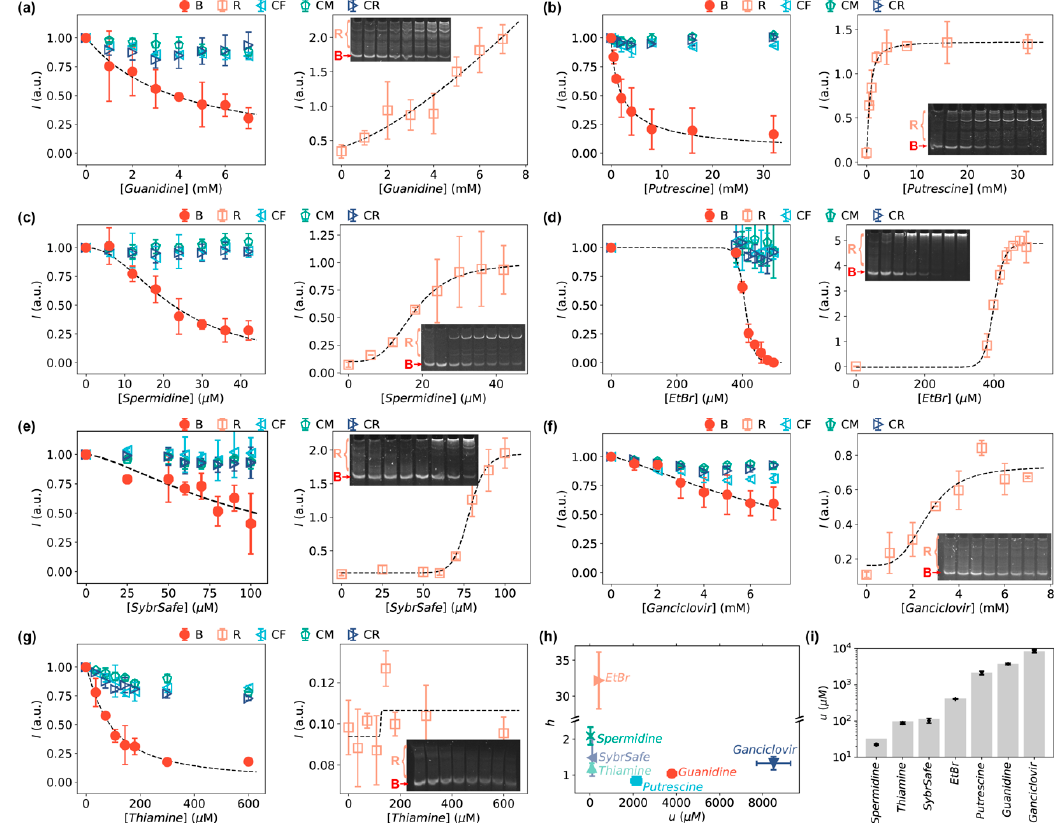
Figure 4. Intensities of the bands of DNA bows (red circles), relaxed DNA loops (orange squares), and linear DNA controls (cyan triangles, green pentagons, blue triangles) in the presence of small organic molecules at increasing concentrations: ( a ) guanidine, ( b ) putrescine, ( c ) spermidine, ( d ) ethidium bromide, ( e ) SYBR safe, ( f ) ganciclovir, and ( g ) thiamine. Insets are the representative, cropped gels of bent DNA bows in the presence of the corresponding small organic molecules at increasing concentrations. The corresponding full-length gels are shown in Figure S2. Error bars in panels a–g represent the standard deviation from 2–4 replicates. ( h ) Fitted ℎ and 𝑢 values from the modified Hill equation for the organic molecules. ( i ) Fitted 𝑢 -values for quantifying the strength of DNA interactions with organic molecules.